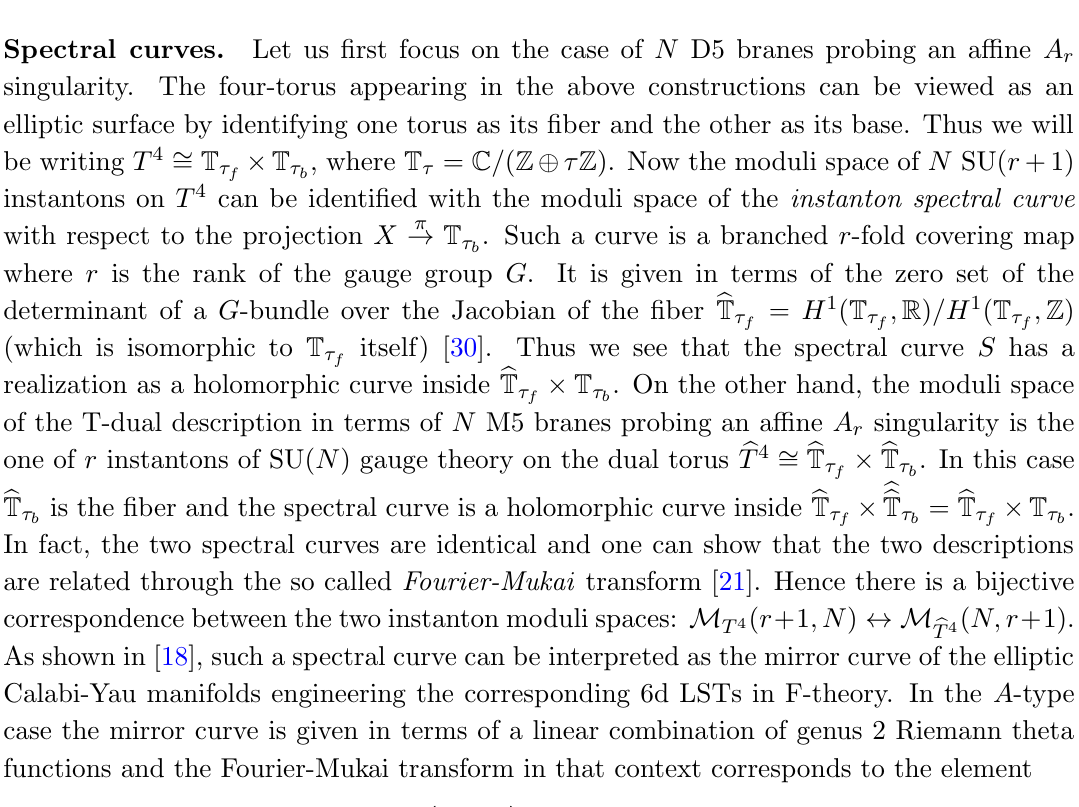
Figure 2 . Brane setup for a 3d A D 4 T